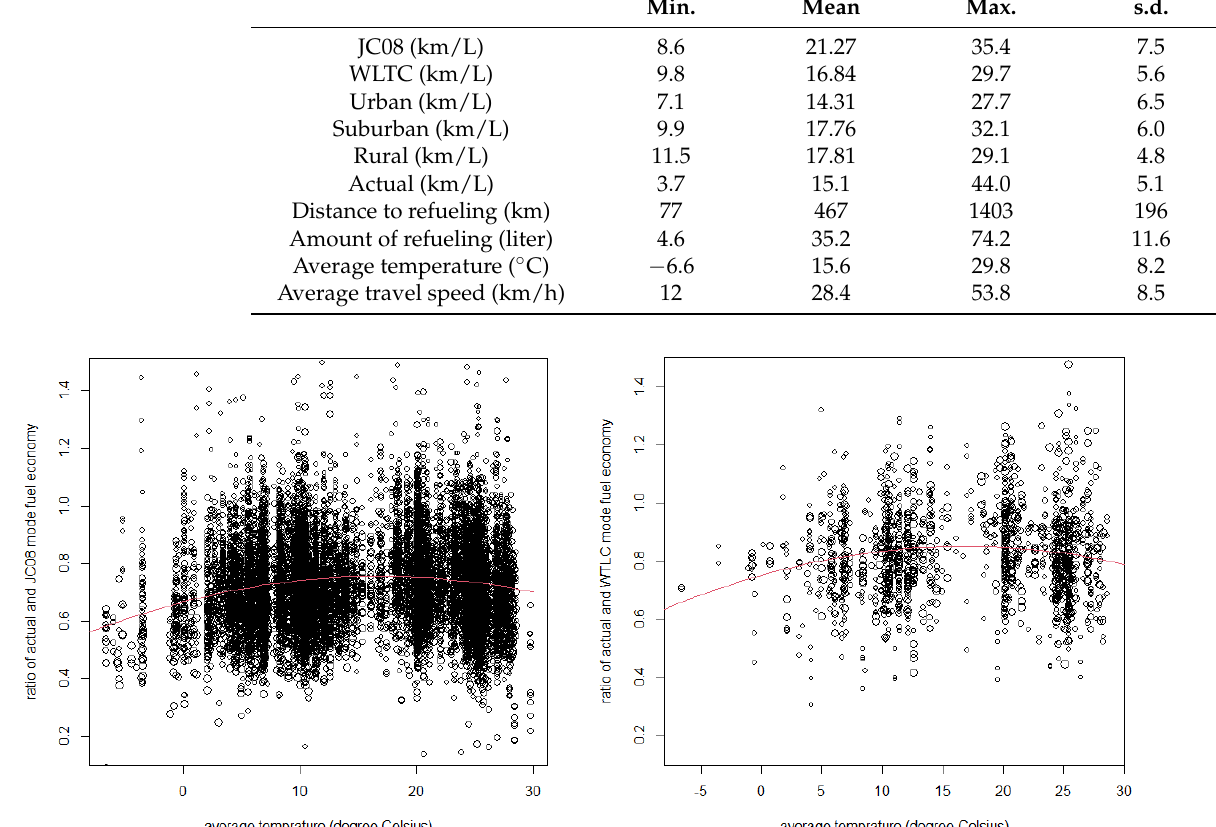
Figure 3. The relationship between the average temperature and the fuel economy ratio when using the JC08 mode ( left ) and the WLTC mode ( right ) as a test fuel economy.